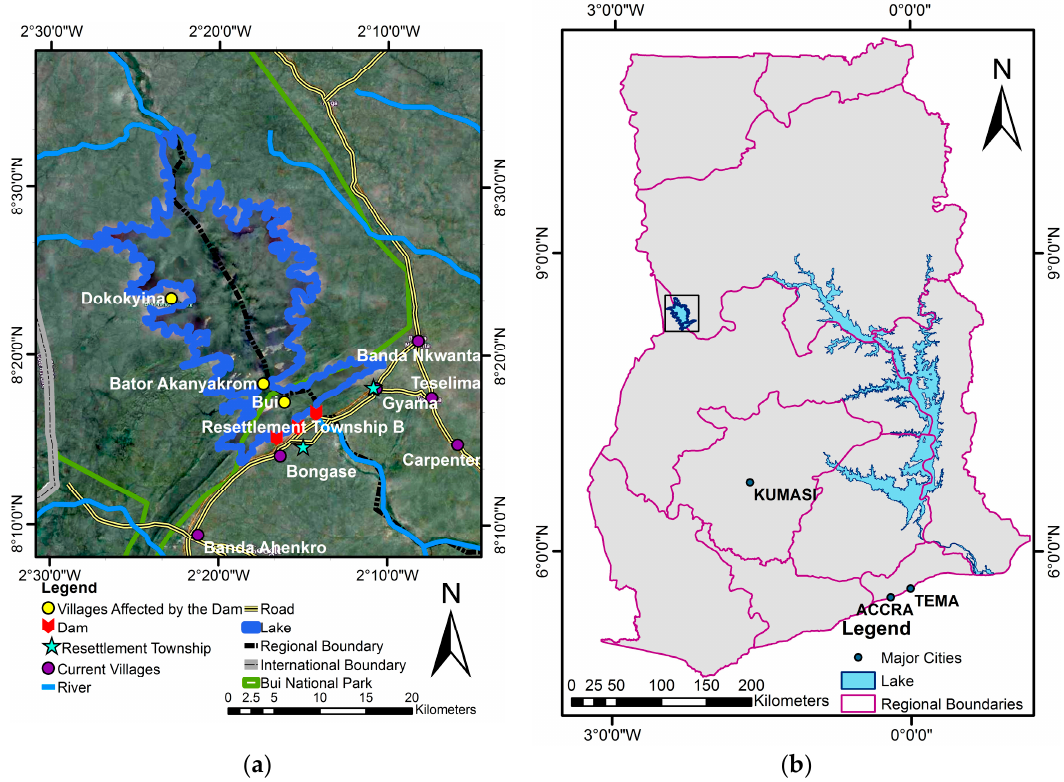
Figure 1. ( a ) Map showing the Bui Dam, the dam catchment area and the resettlement townships; ( b ) map of Ghana showing the location of the Bui Dam.